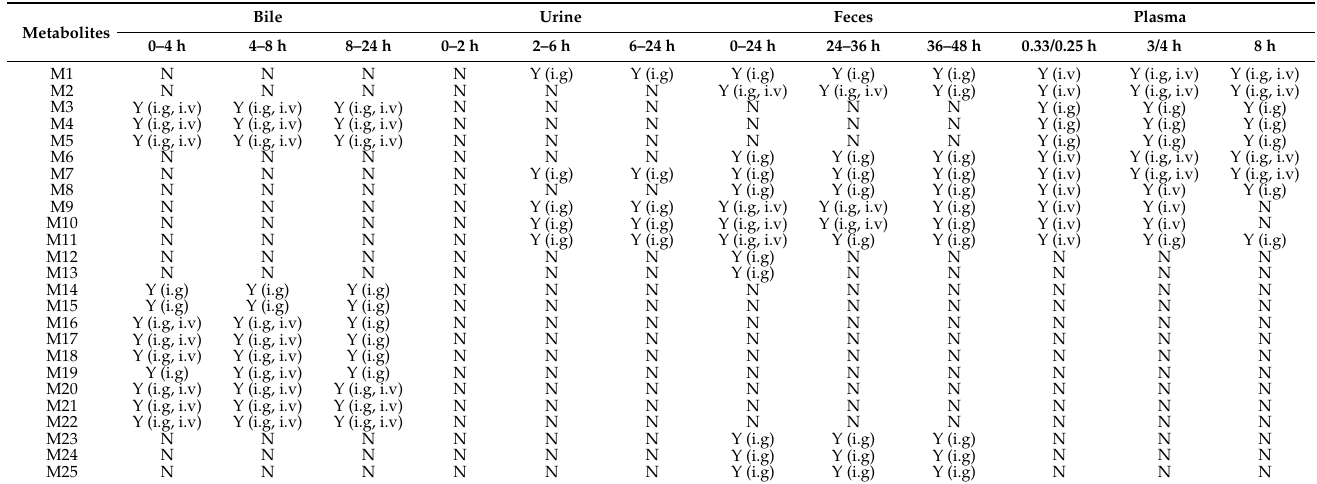
Table 2. Metabolites of PND in rat bile, urine, feces and